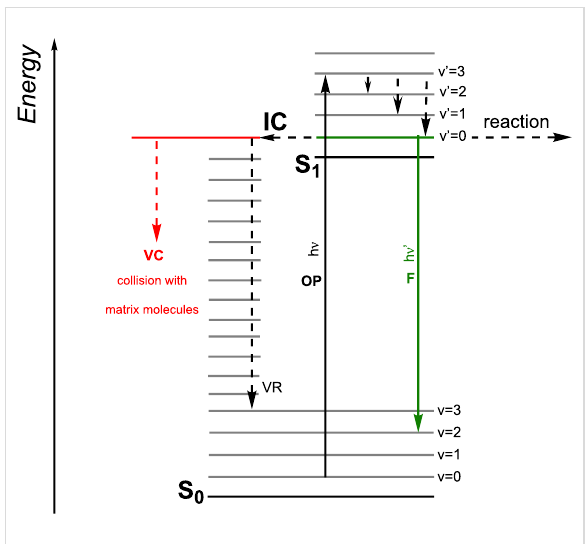
Figure 1: Simplified process chart of photophysical processes occur- ring in NIR absorbers.